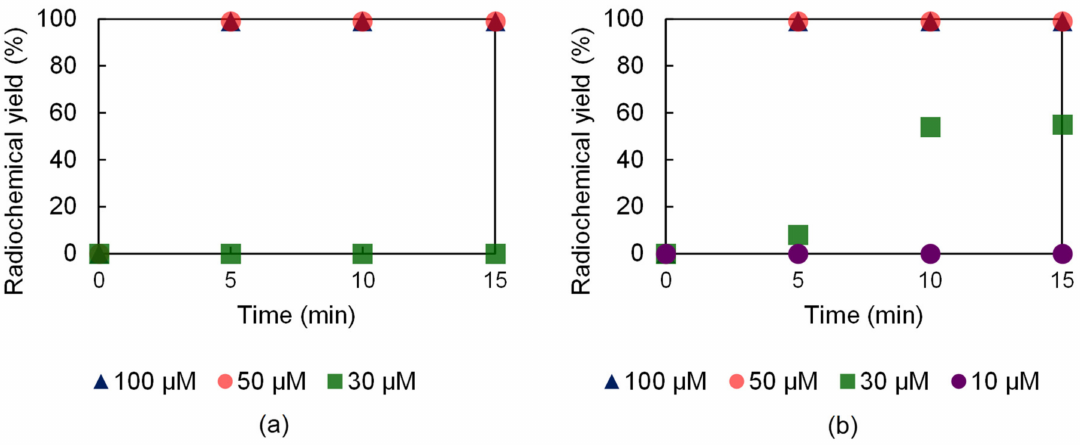
Figure 5. 52 Mn labeling effectiveness of H 2 3,9-PC2A ( a ) and H 2 3,9-OPC2A ( b ) at 95 ◦